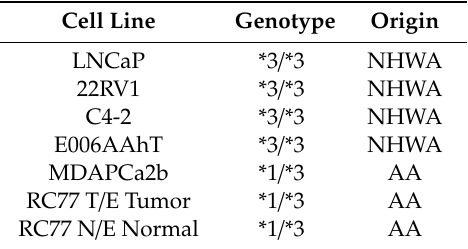
Table 1. CYP3A5 polymorphism analysis of commonly used prostate cancer cell